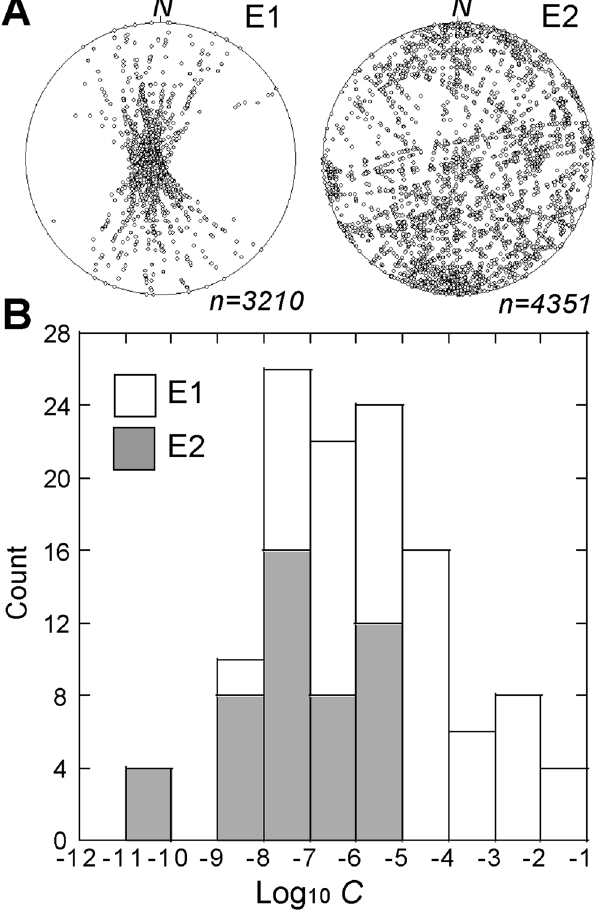
Figure 3. ( A ) Spatial distribution of the potential vein intersections in the E1 and E2 alteration zones (beta- plot; equal area Schmidt net, lower hemisphere). ( B ) Histogram of the calculated C values of the E1 and E2